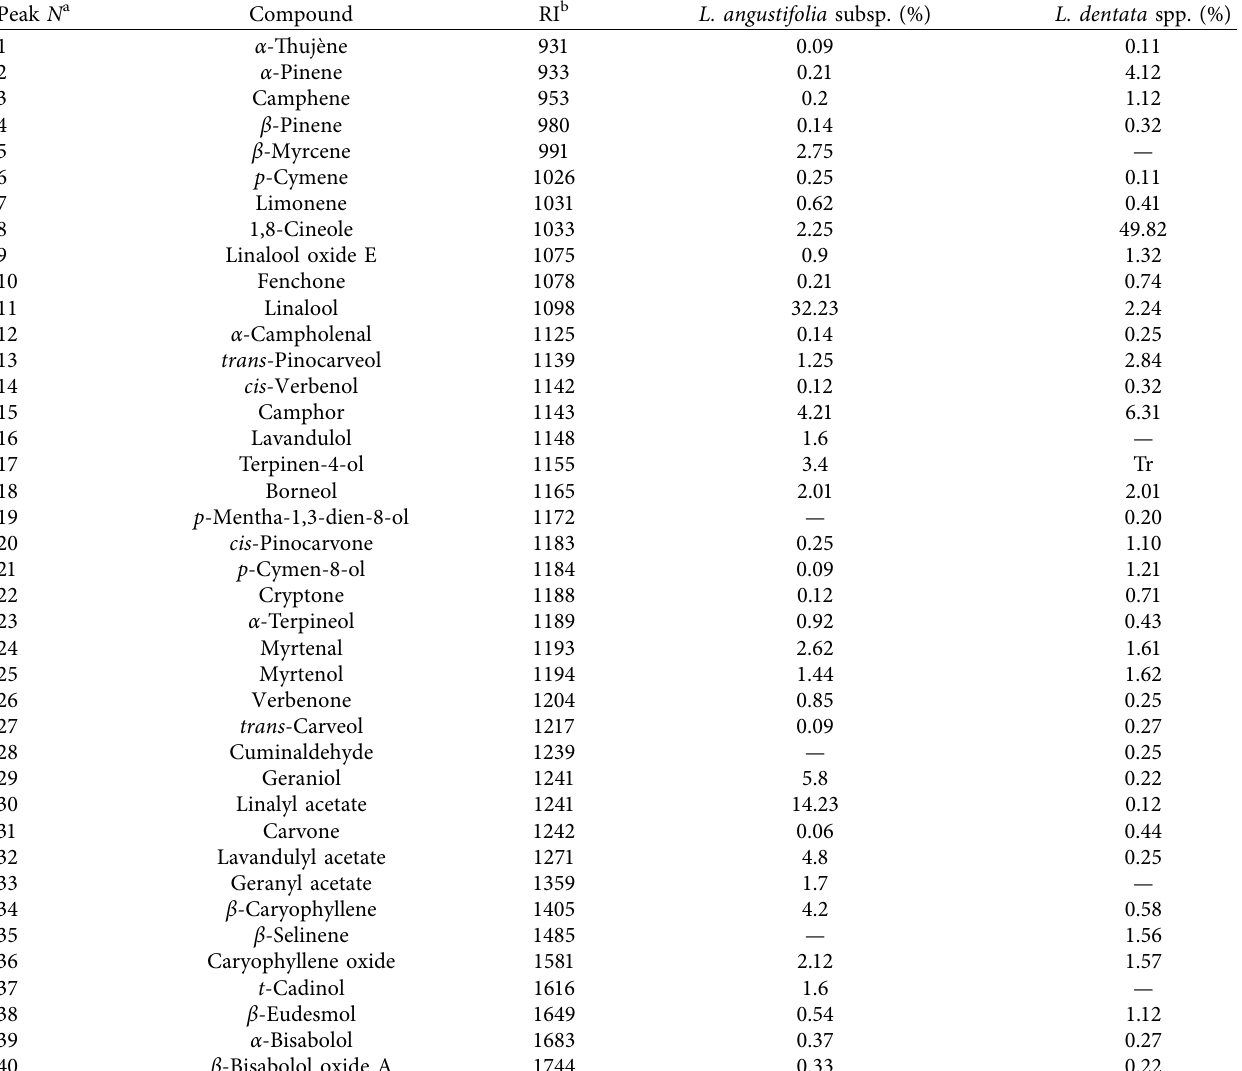
Table 1: Chemical composition of L. angustifolia subsp. and L. dentata spp. essential oils.